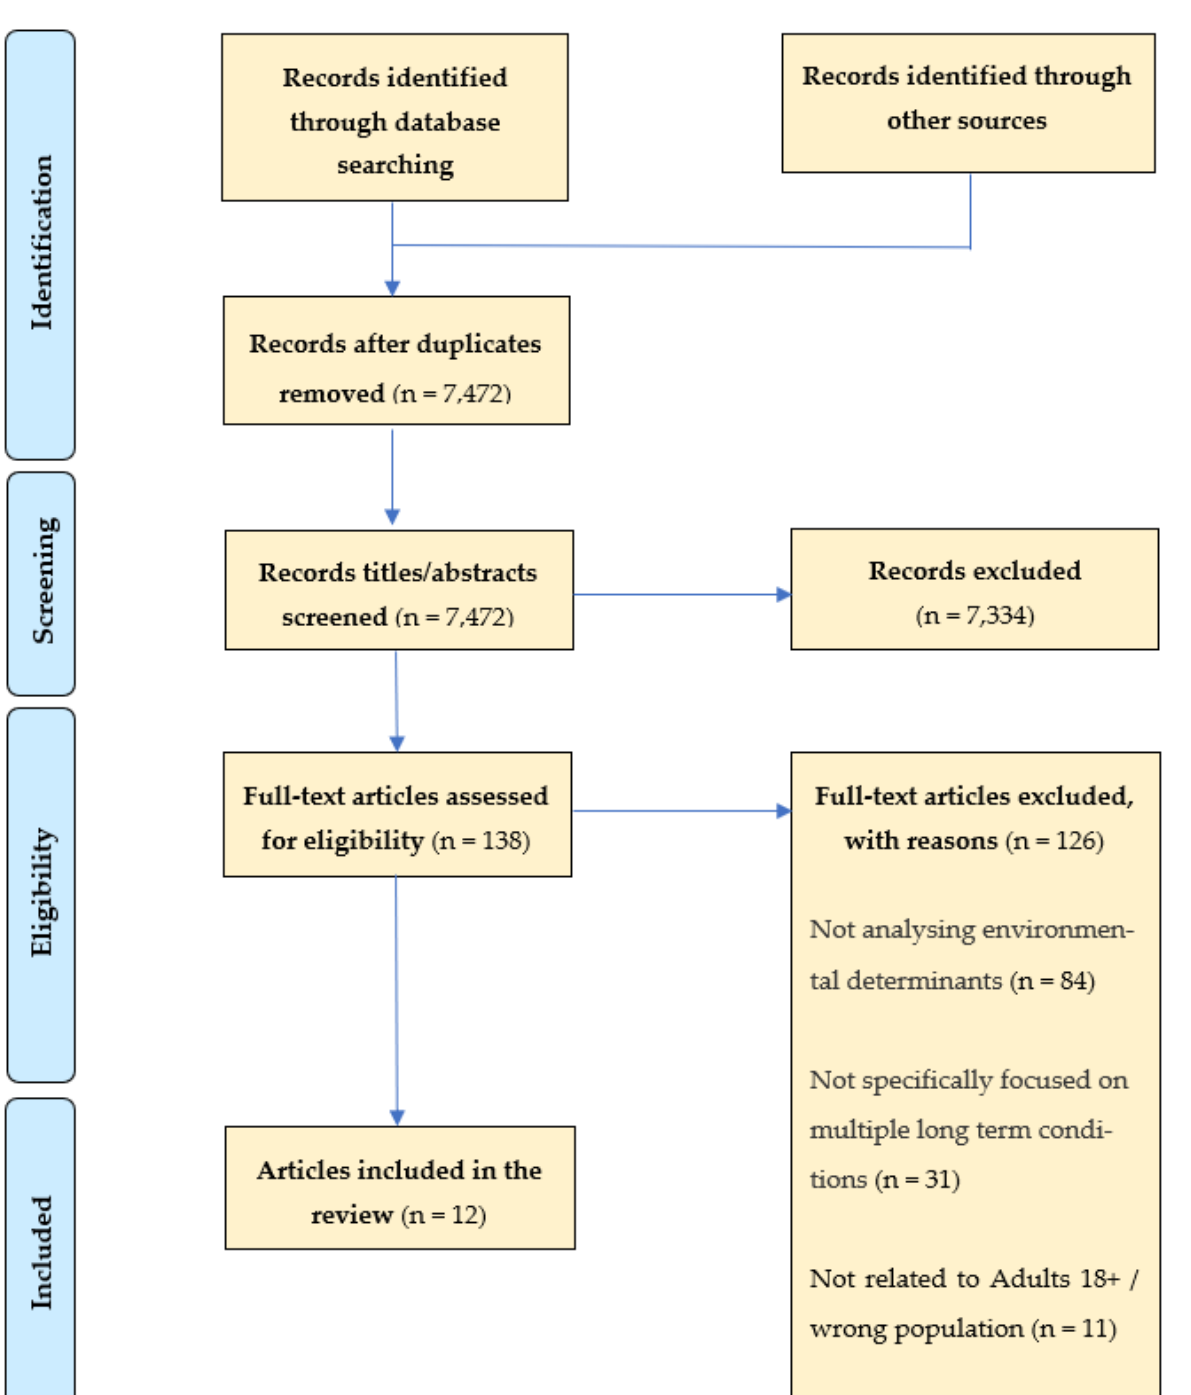
Figure 1. Adapted PRISMA Flow Chart. Explaining the study’s documentary screening and inclusion/exclusion process.